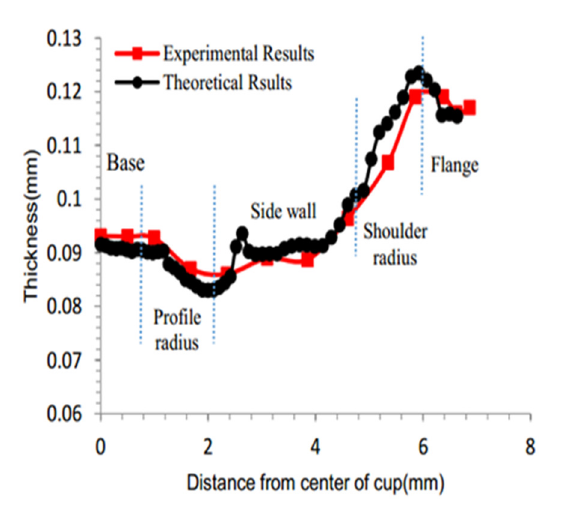
Fig. 14. Thickness distributions of wall cup at rolling